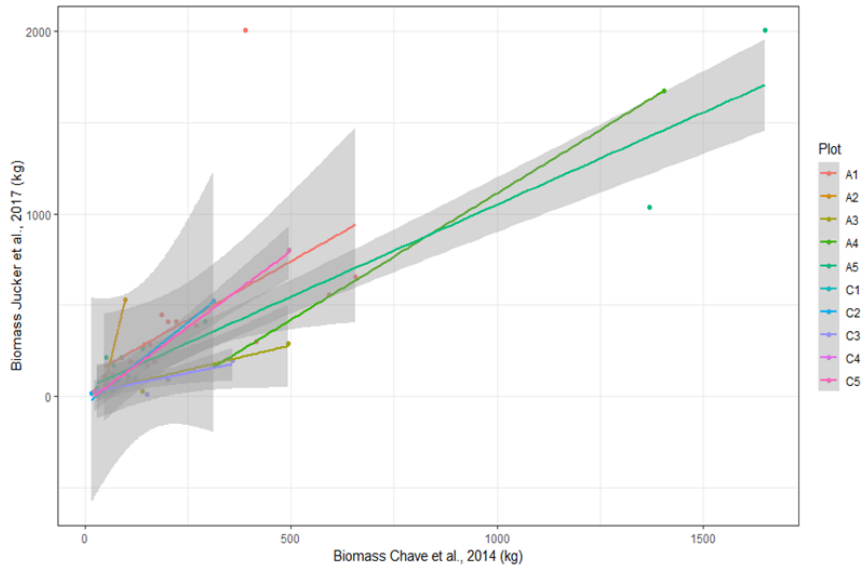
Figure 7. Comparison of biomass estimates from values measured on the field using equation from Chave et al., 2014, and Jucker et al., 2017.